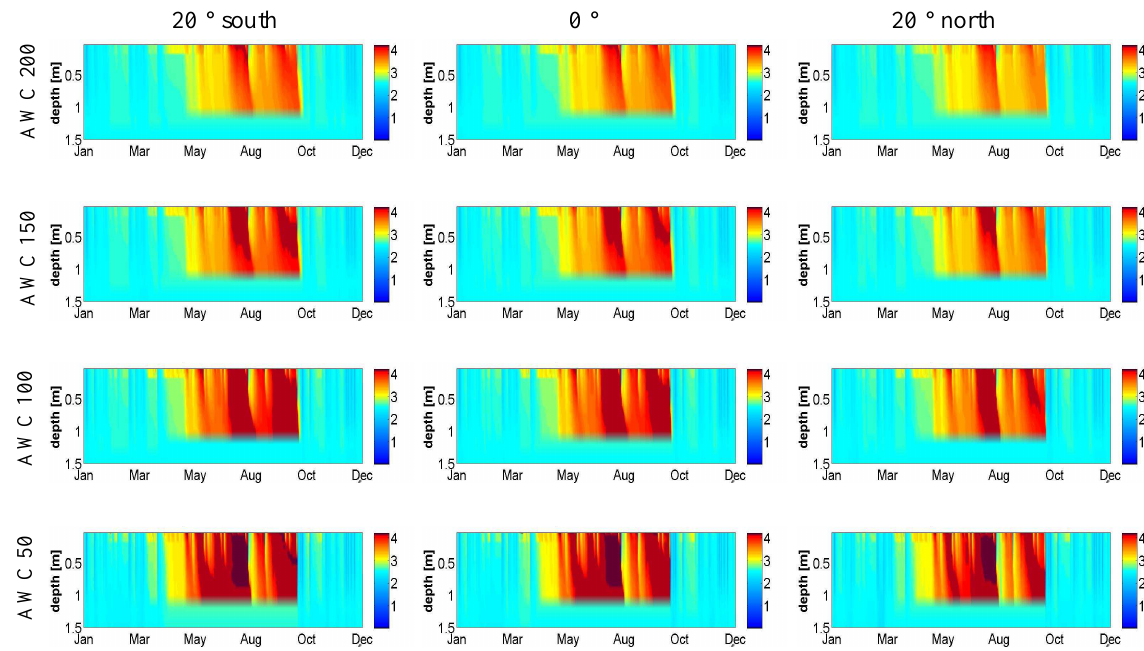
Fig. 1. Simulated soil water tension in pF up to 1.5m depth for all site variations and the year 1982; with climate data of the station “Deuselbach”, Germany.